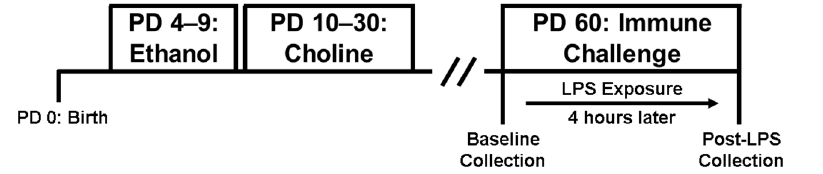
Figure 1. Overview of experimental design. Timeline and overview exposure groups: ethanol exposure from postnatal day (PD) 4–9 (left), choline supplementation from PD 10–30 (middle), and immune challenge of lipopolysaccharide (LPS) on PD 60 (right).